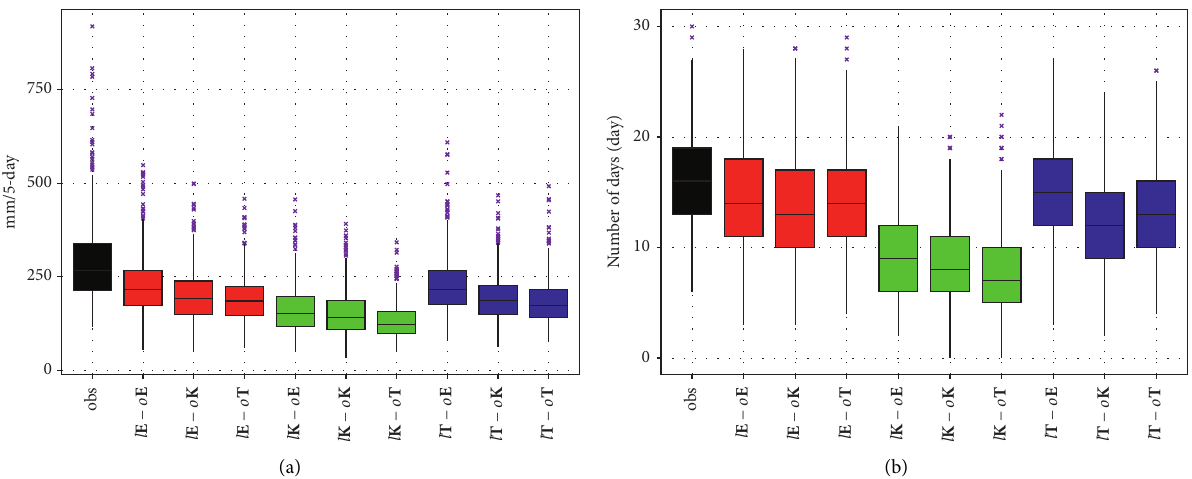
Figure 8: (a) Boxplots of annual maximum consecutive 5-day accumulative precipitation and (b) number of days with precipitation exceeding 20mm/day using the 10-year JJAS derived from the in-situ observation and model simulations interpolated to the station sites. The thick black line within each box represents the median value.